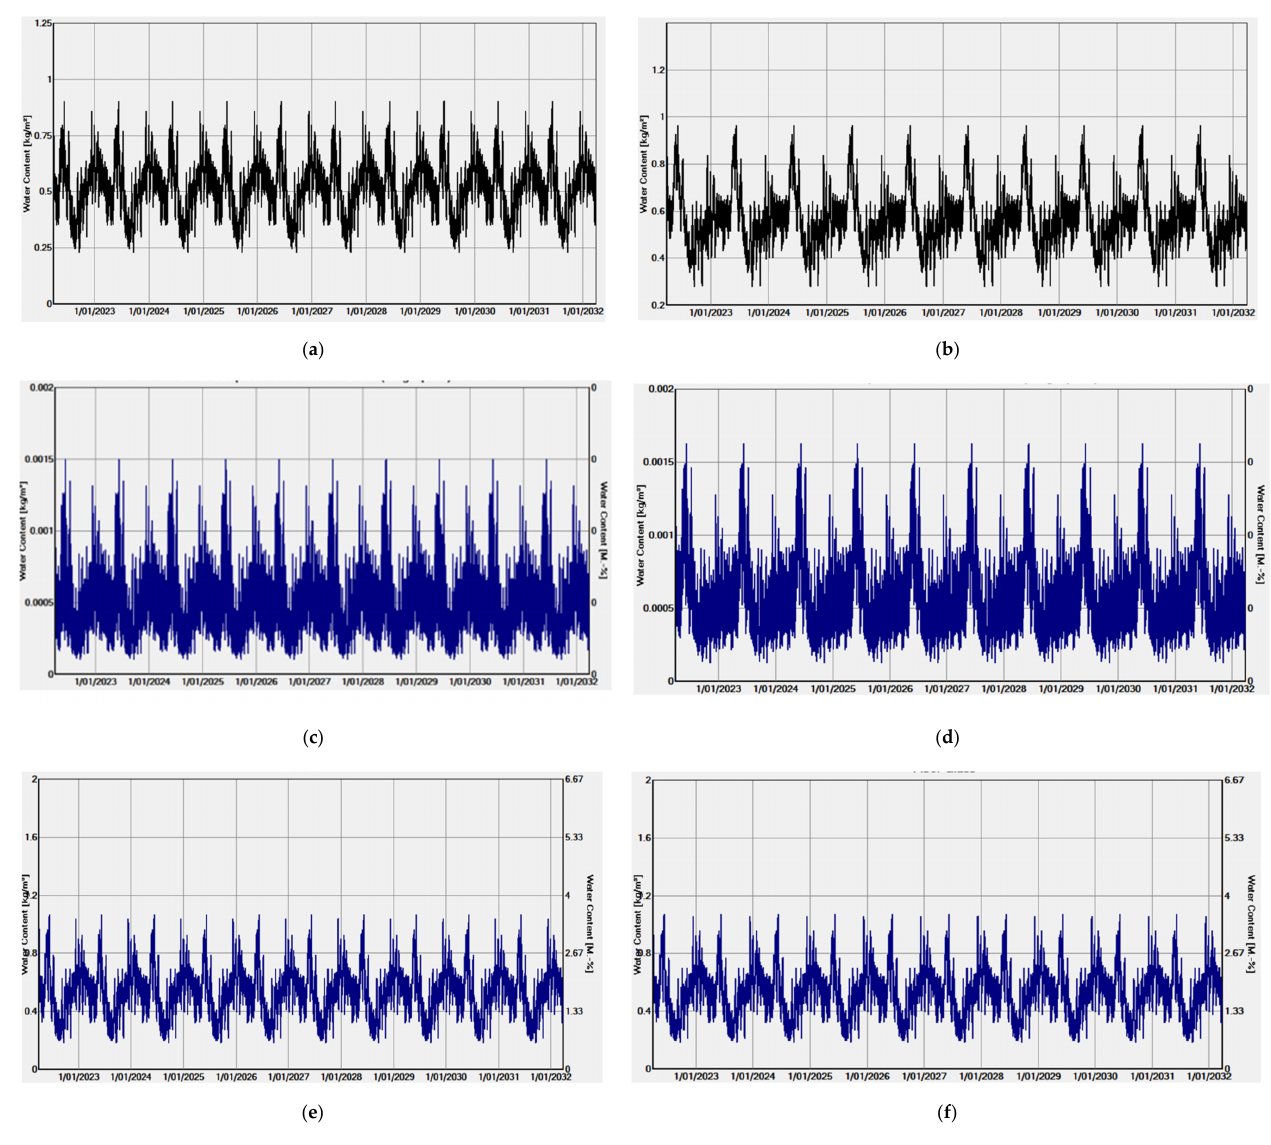
Figure 9. ( a – f ): Selected hygrothermal simulation results of the moisture content for Pliable membranes A and B for Sydney. ( a ): Total moisture content of the wall assembly in northern orientation when either single or multipoint water vapour resistivity values of pliable membrane A and B. ( b ): Total moisture content of the wall assembly in western orientation when either single or multipoint water vapour resistivity values of pliable membrane A and B. ( c ): Moisture content of the vapour control layer in northern orientation for pliable membrane A and B with both single and multipoint water vapour resistivity values. ( d ): Moisture content of the vapour control layer in western orientation for pliable membrane A and B with both single and multipoint water vapour resistivity values. ( e ): Insulation, fibre glass (single point). ( f ): Insulation, fibre glass (multipoint).